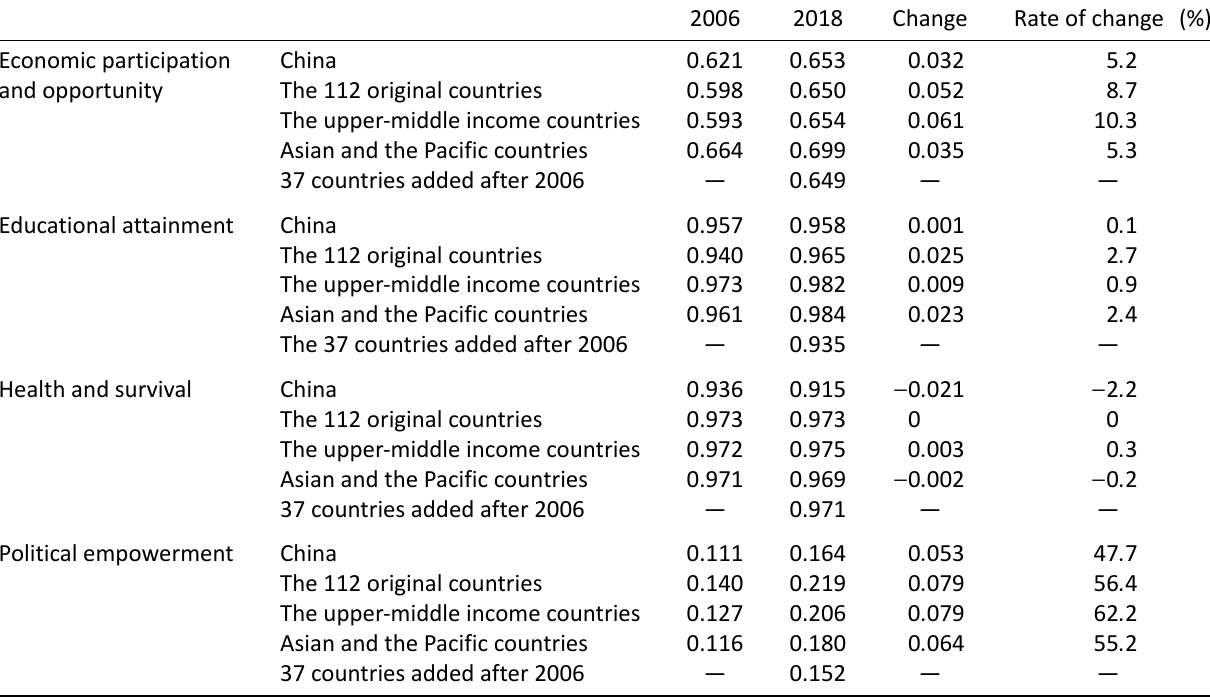
Table 2. Comparison of the scores of China and other countries in four